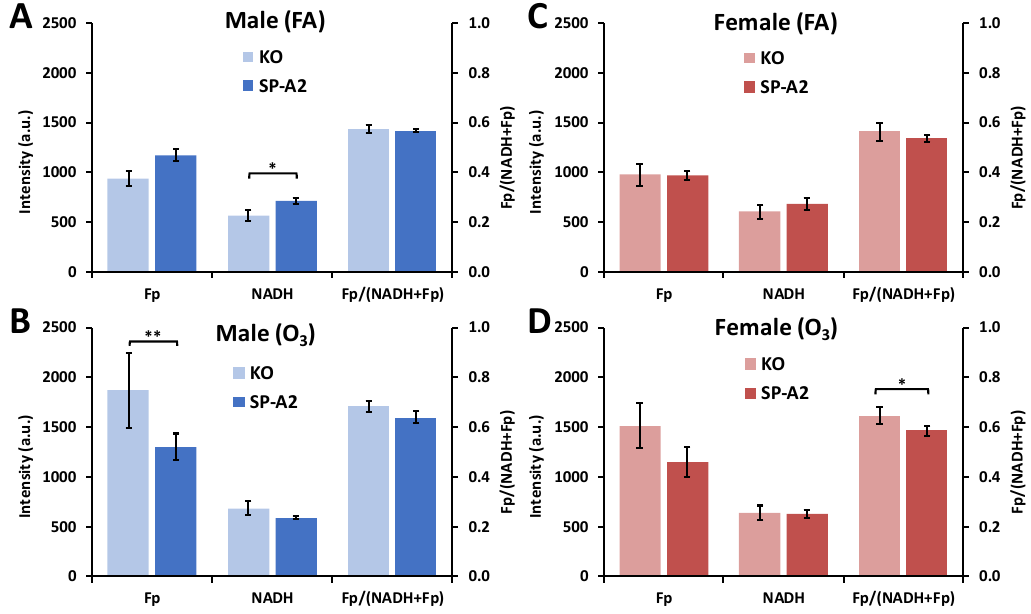
Figure 8. SP-A2-associated redox differences in AM from male ( A and B ) and female ( C and D ) mice exposed to FA ( A and C ) or O 3 ( B and D ) (Mean ± SD). * p < 0.05, ** p < 0.01.